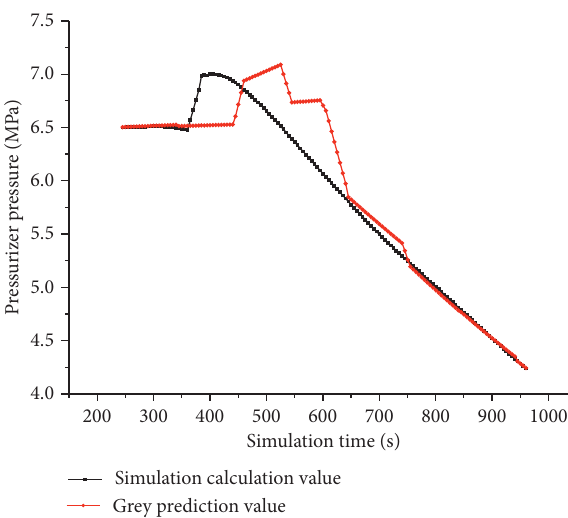
Figure 10: The comparison of actual and predicted data of the steam generator water level.